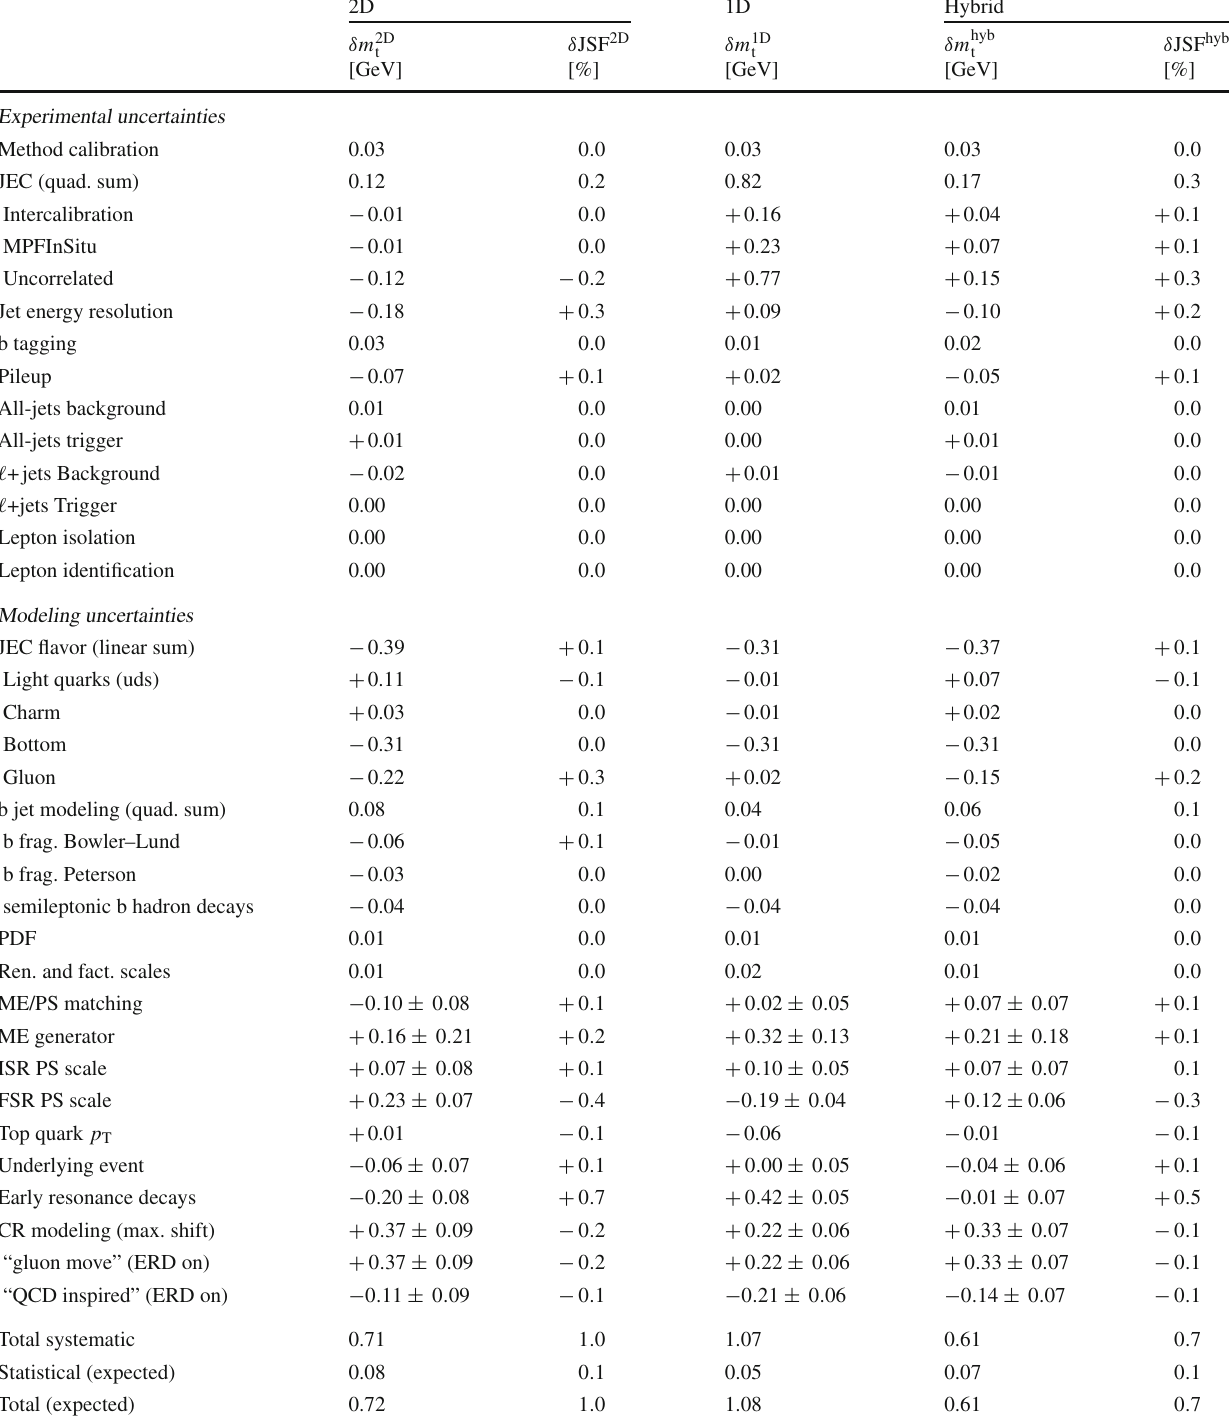
Table 2 List of systematic uncertainties for the combined mass extrac- tion. The signs of the shifts ( δ x = x variation − x nominal ) correspond to the + 1 standard deviation variation of the systematic uncertainty source. For linear sums of the uncertainty groups, the relative signs